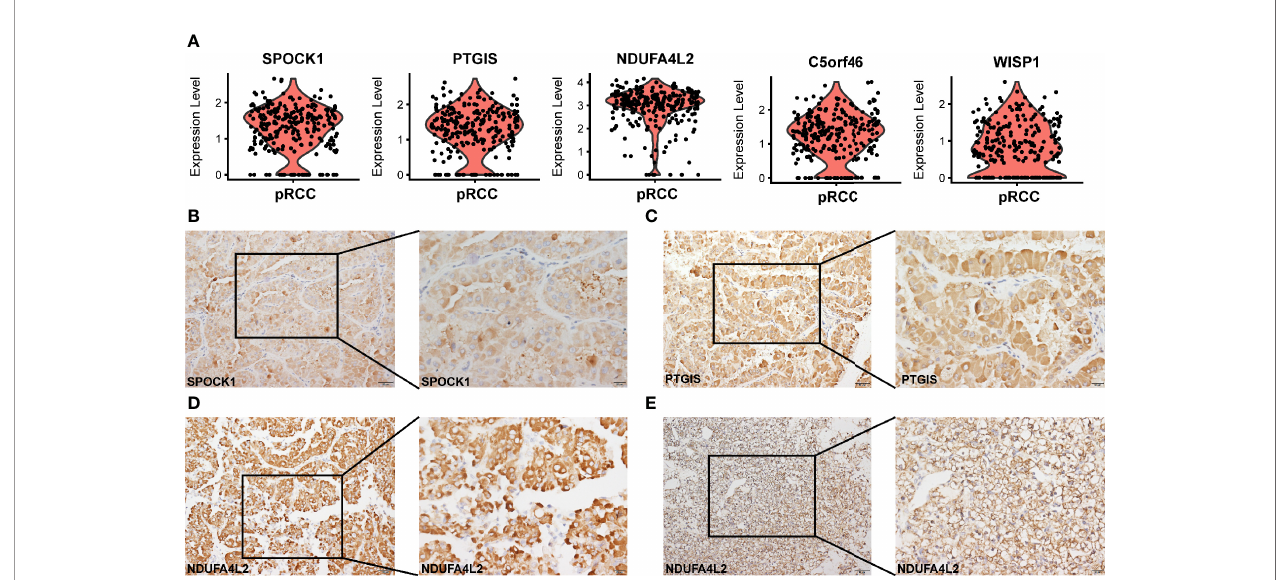
FIGURE 3 | Tumor-speci fi c markers in different types of pRCC. (A) Violin plots showing tumor-speci fi c markers expressed in type 2 pRCC. (B – D) IHC-P veri fi cation of tumor-speci fi c markers ( SPOCK1, PTGIS and NDUFA4L2 ) in type 2 pRCC ( Table S10 ). Scale bars, 20 m m (left) and 50 m m (right). (E) IHC-P veri fi cation of tumor-